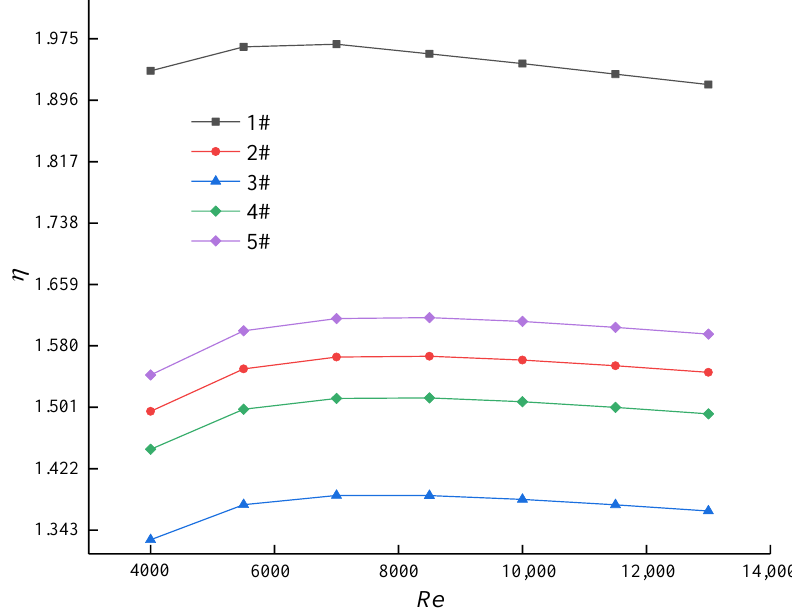
Figure 9. Evaluation of overall convection heat transmission performance for SCPs.